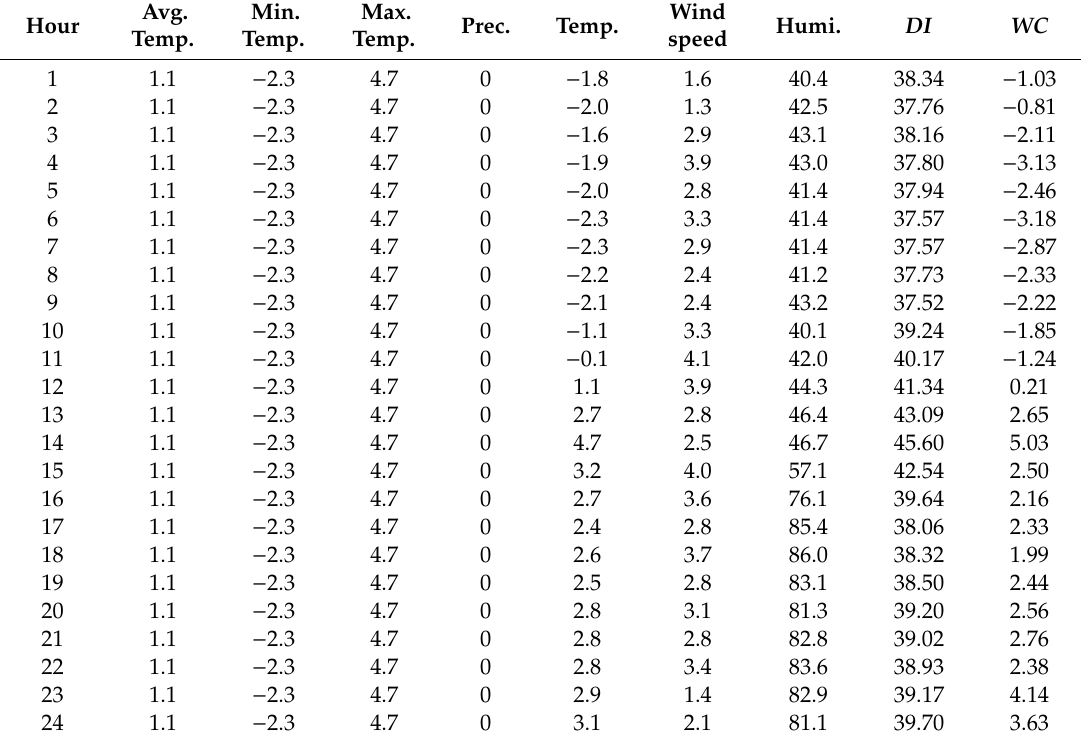
Table 5. An example of weather conditions on December 25,